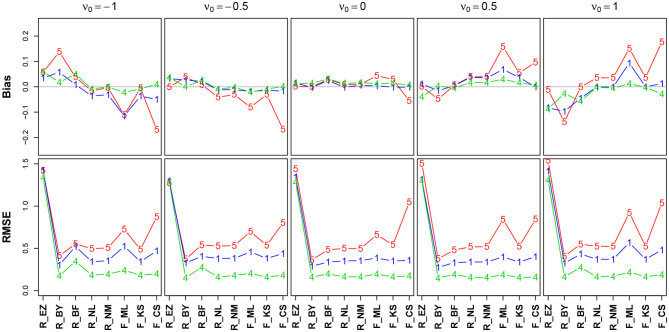
Bias (upper row) and RMSE (lower row) of the drift parameter ν. red line/symbol “5”: 50 trials; blue line/symbol “1”: 100 trials; green line/symbol “4”: 400 trials; for abbreviations see Figure 3.